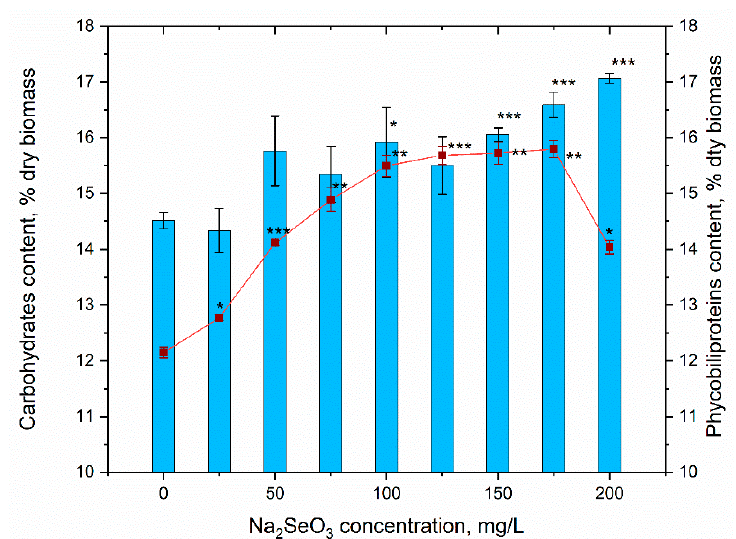
Figure 5. The content of carbohydrates and phycobiliptoteins in Arthrospira platensis biomass under conditions of supplementing the nutrient medium with sodium selenite (* p < 0.05, ** p < 0.005, *** p < 0.0005 for differences between control and experimental sample; n = 3). The error bars represent the standard deviation of the measurements.